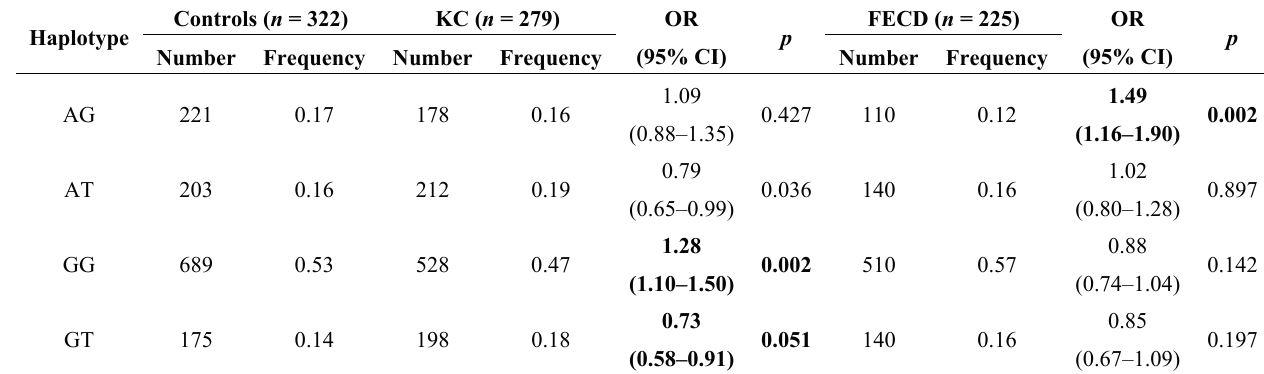
p < 0.05 along with corresponding ORs are in